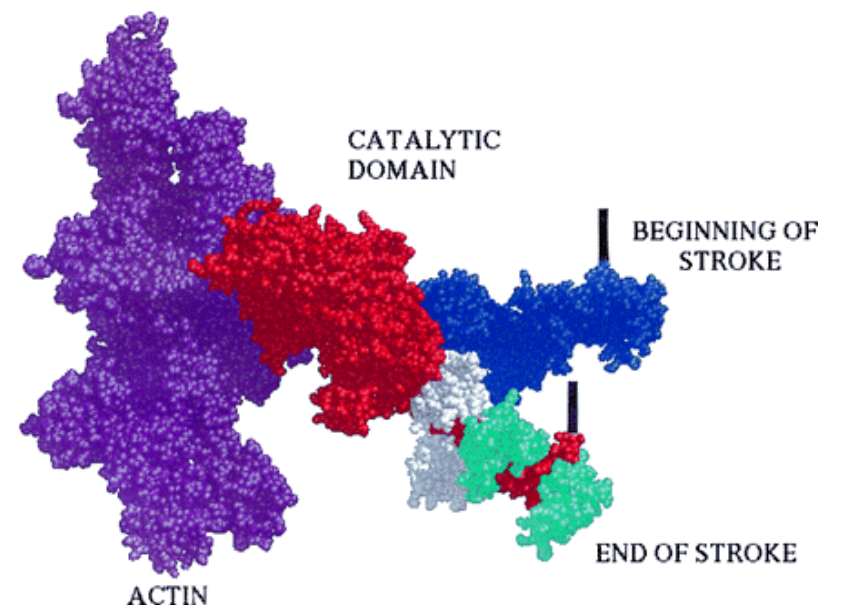
Figure 2. A model of the actomyosin complex illustrates how the spectroscopic results described by Baker et al [11]. Copyright (1998) National Academy of Sciences,